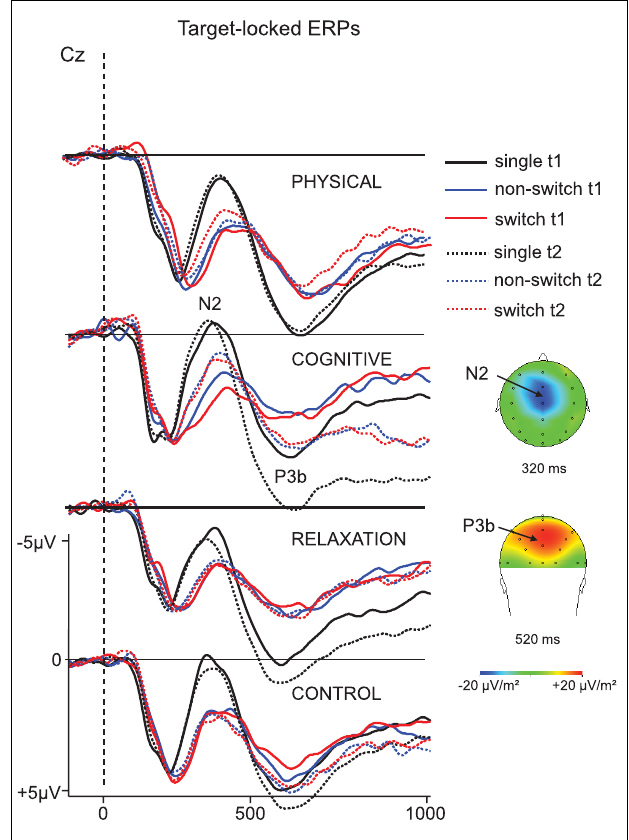
FIGURE 3 |Target-locked ERP – waveforms in correct trials as a function of the three trial types (single task, non-switch and switch trials) and the pre- ( t 1; solid) and post-measure ( t 2; dotted) for each group at electrode Cz. The distribution of the N2 and P3b is visualized in form of topographical maps that illustrate the current densities at 320ms for the N2 and at 520ms for the P3b. Dashed line indicates target onset. Negativity is plotted